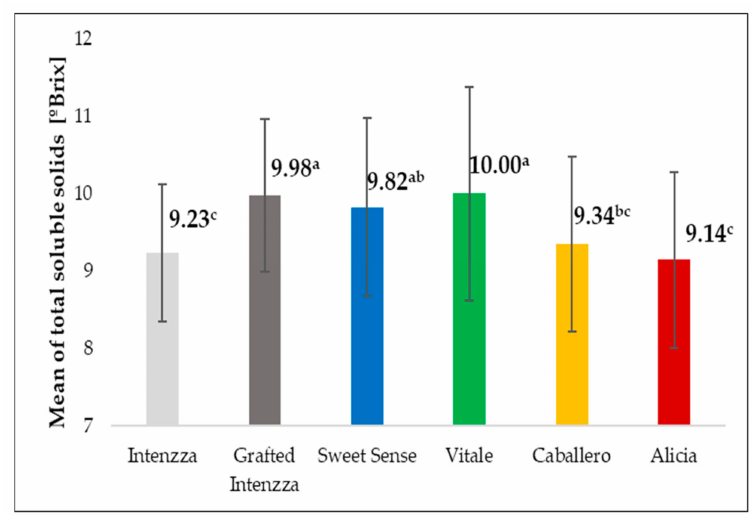
Figure 6. Average of the total soluble solids (TSS) measured of fruits of papaya cultivated under greenhouse. Di ff erent letters mean significant di ff erences, at p -value < 0.05.